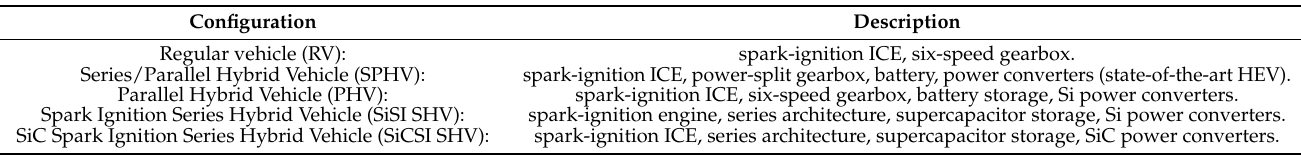
Table 11. Different powertrain vehicle structures.